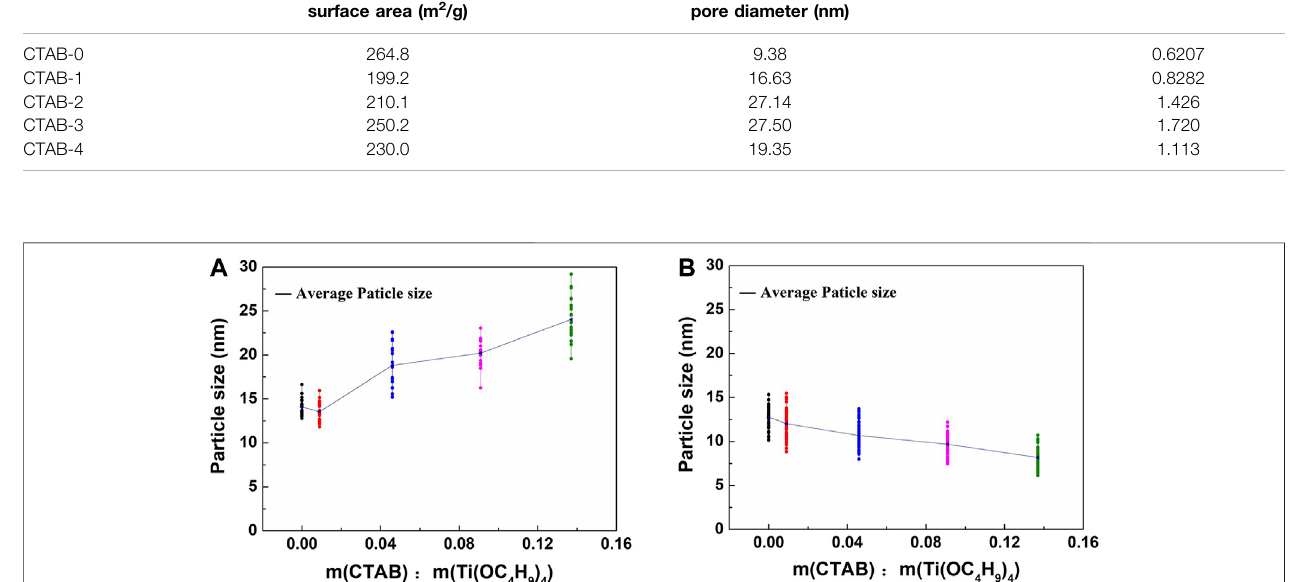
FIGURE 6 | Particle size measurements of (A) TiO 2 aerogels without the calcination, (B) 300 ° C-calcined TiO 2 aerogels.